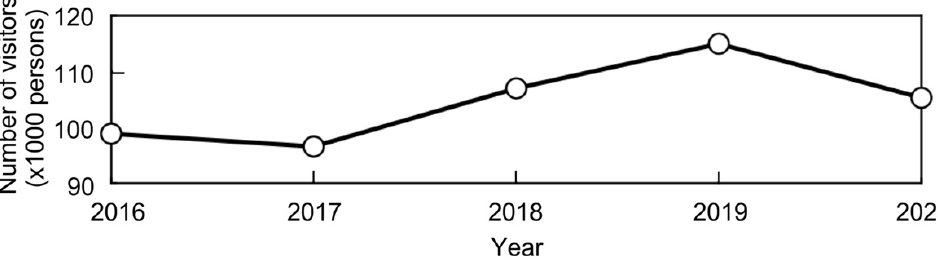
Figure 3. The estimated annual number of visitors to the mountains of Daisetsuzan National Park from 2016 to 2020 (Compiled from unpublished data provided by the Ministry of the Environment).